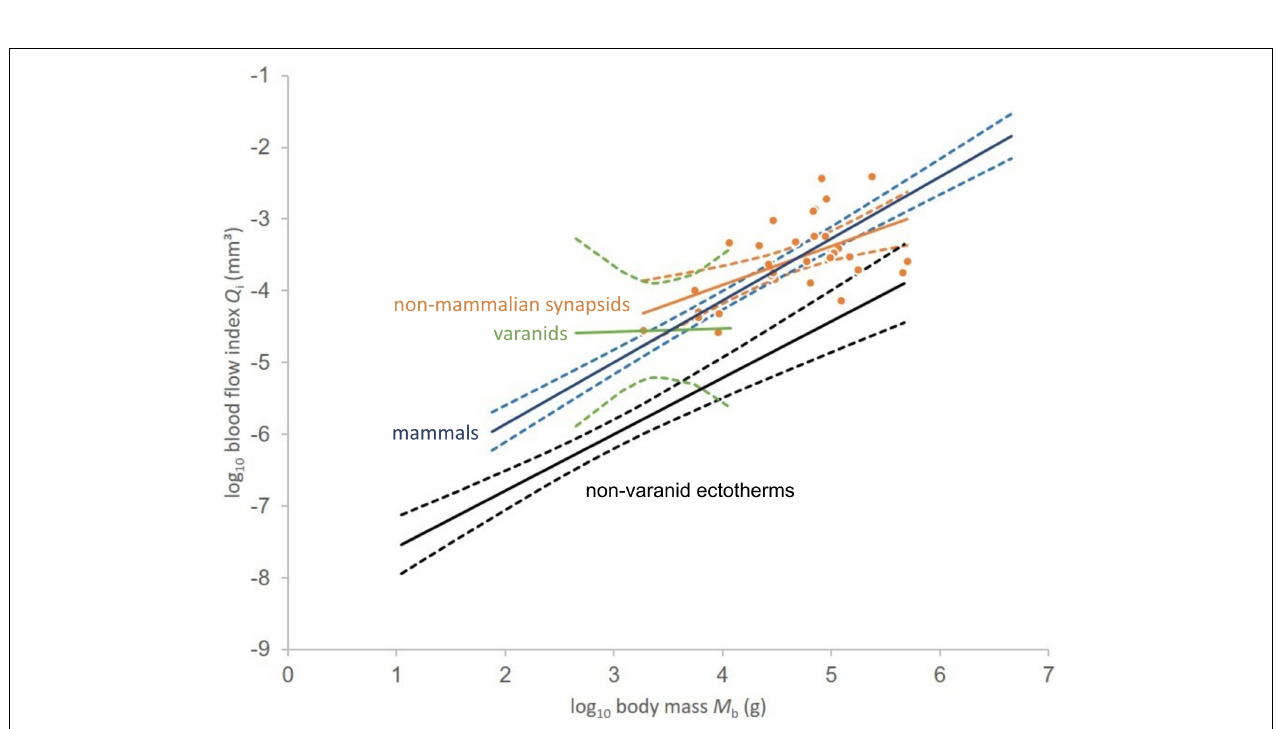
FIGURE 3 | Relationship between logarithms of blood flow index and body mass for non-mammalian synapsids (orange dots). Linear least squares regressions in solid lines given for non-mammalian synapsids ( Q i = 0.5416M b – 6.0844), mammals ( Q i = 0.8619M b – 7.5806), varanids ( Q i = 0.0421M b – 4.6942), and non-varanid ectotherms ( Q i = 0.7865M b – 8.3534). Respective 95% confidence intervals of the regression mean indicated by dashed lines. Data except non-mammalian synapsids from Seymour et al. (2012).